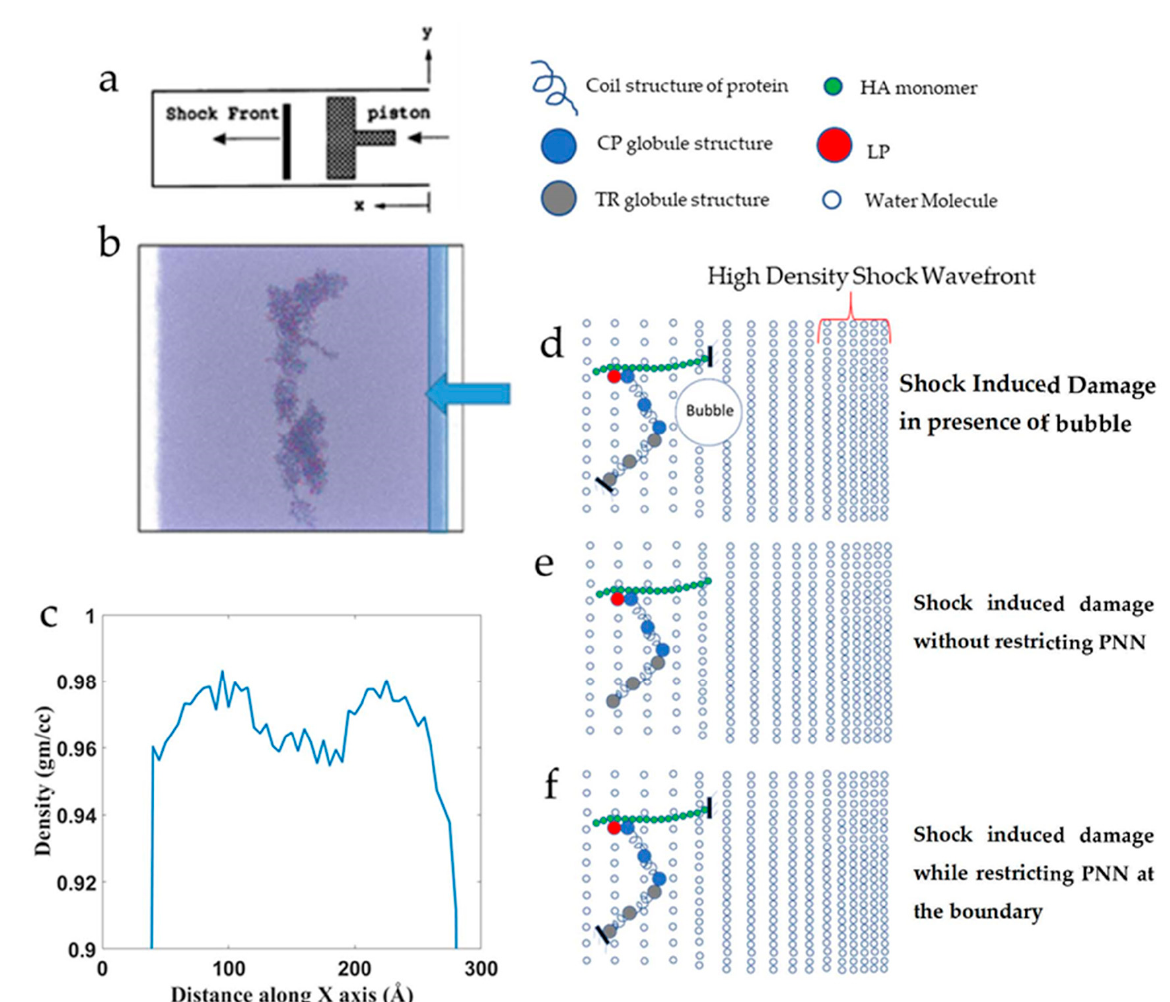
Figure 4. The simulation box for shock propagation. ( a ) Schematic illustration of the shock simulation setup. ( b ) Snapshot of the shock simulation box by the OVITO visualization tool. ( c ) Density profile along the shock direction. ( d – f ) Schematic illustration of the simulation protocol ( d ) while restricting the PNN in the presence of bubble, ( e ) without restricting the PNN, and ( f ) with re-